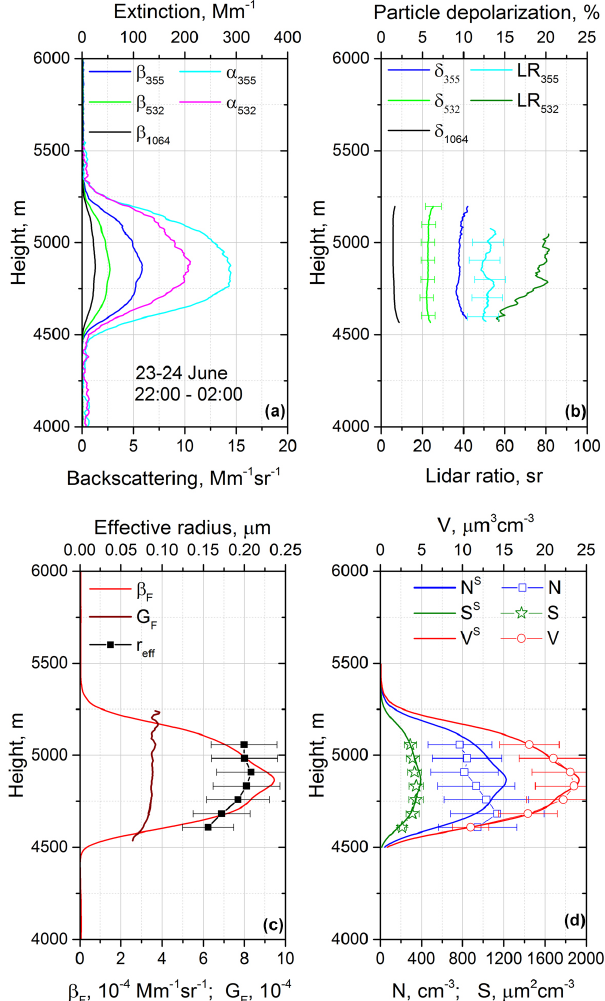
Figure 5. Smoke layer on 23–24 June 2020. (a) Vertical profiles of backscattering ( β 355 , β 532 , β 1064 ) and extinction ( α 355 , α 532 ) co- efficients. (b) Particle depolarization ratios ( δ 355 , δ 532 , δ 1064 ) and lidar ratios (LR 355 , LR 532 ). (c) Fluorescence backscattering ( β F ), fluorescence capacity ( G F ) and the particle effective radius ( r eff ). (d) Number ( N , N S ), surface area ( S , S S ) and volume ( V , V S ) concentrations obtained by inversion of 3 β + 2 α observations (sym- bols) and calculated from the fluorescence backscattering (lines) by using the mean conversion factors defined in Eq.